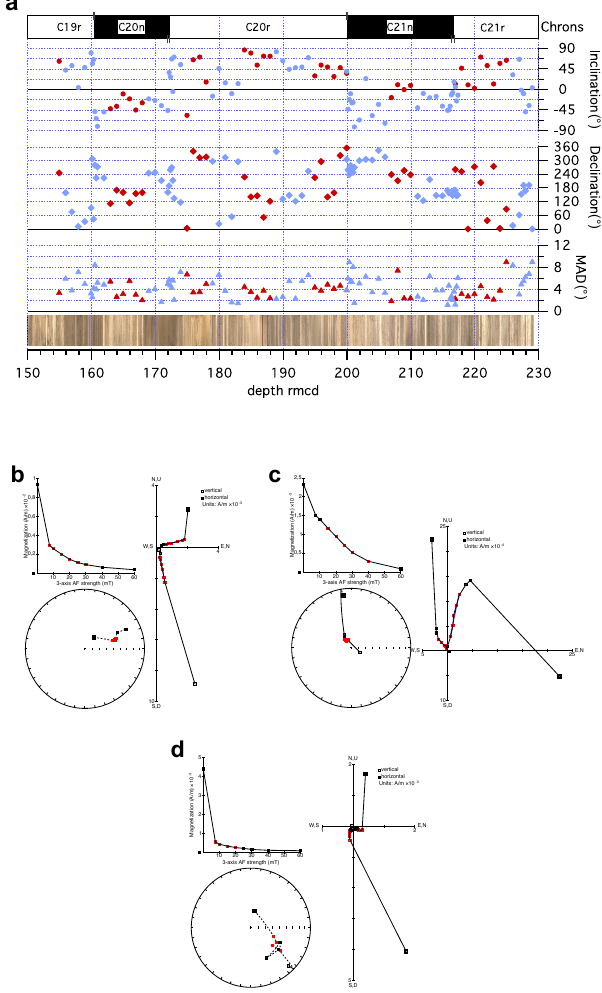
Figure 3. Magnetic property data and Zijderveld plots for ODP Site 1263. (a) Inclination (dots), declination (diamonds) and MAD (triangles) of characteristic remanent magnetization obtained from ODP 1263. Red: 1263A; blue: 1263B. (b–d) Showcase Zijderveld plots (Z plots) for samples from C19r 1263B10H1, 140cm (b) ; C21n 1263B14H5, 77cm (c) ; C21r 1263A21H6, 81cm (d) . Zi- jderveld plots were realized with PuffinPlot software (Lurcock and Wilson, 2012). For discussion see